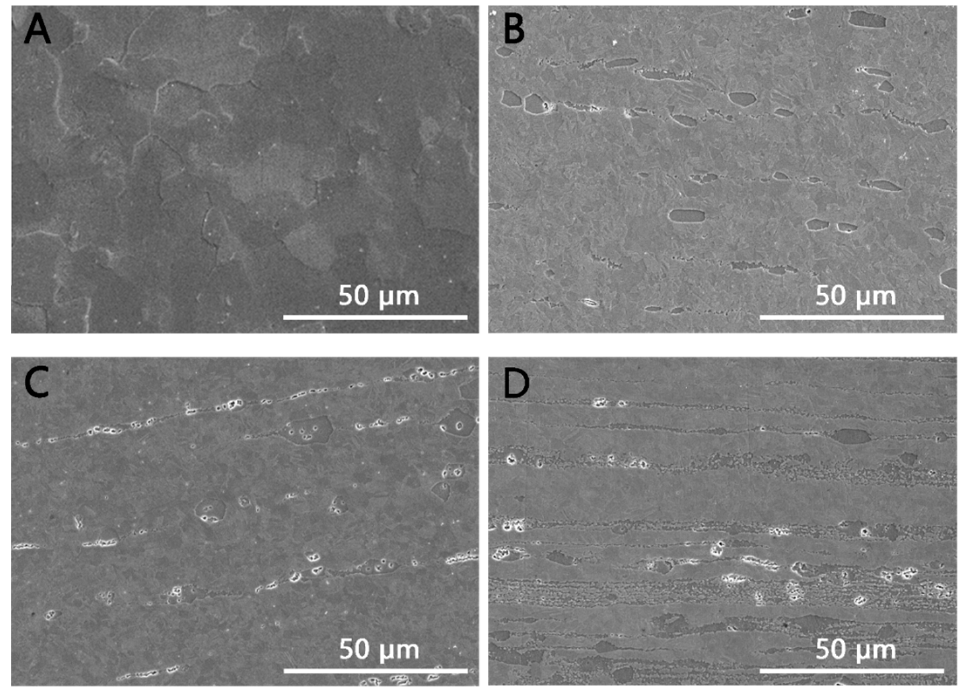
Figure 2. SEM morphologies of the longitudinal section of the as-extruded Zn–Mg alloys. ( A ) Pure Zn; ( B ) Zn–0.2Mg; ( C ) Zn–0.5Mg; ( D ) Zn–1Mg.